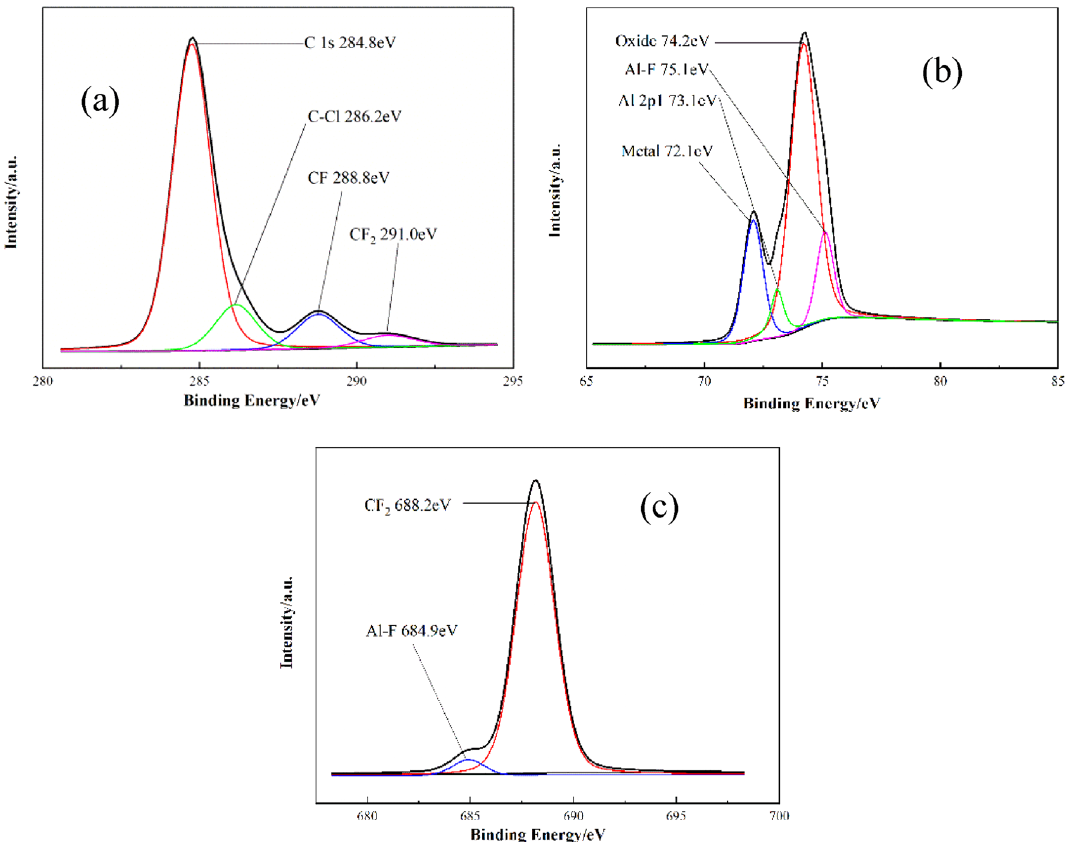
Figure 7. XPS spectra of F2311@Al: ( a ) 1 s orbital of C; ( b ) the 2p orbital of Al; ( c ) the 1 s orbital of